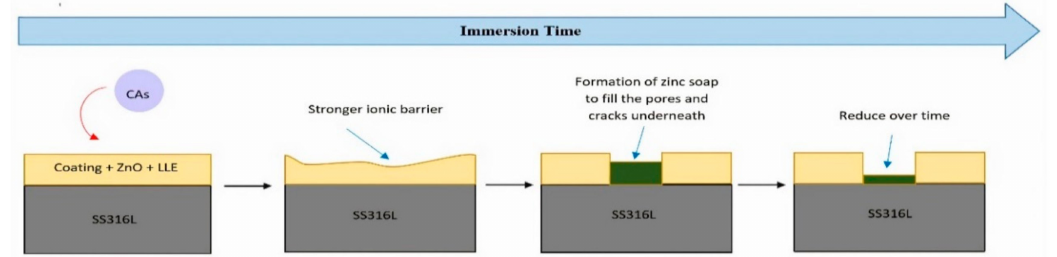
Figure 14. Formation of zinc soap during the rapid oxidation of the